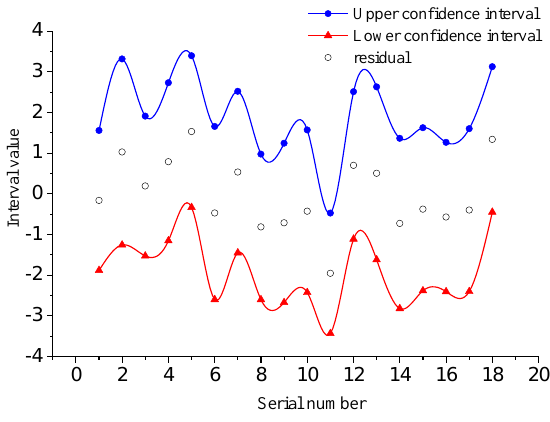
Figure 4. Residual confidence interval.